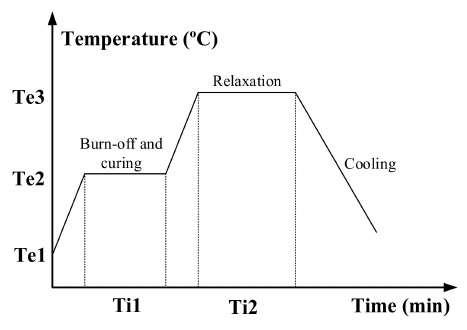
Figure 4. Heat treatment process for the SMC cores. Table 2. Levels of control factors for the heat treatment of SMC cores.